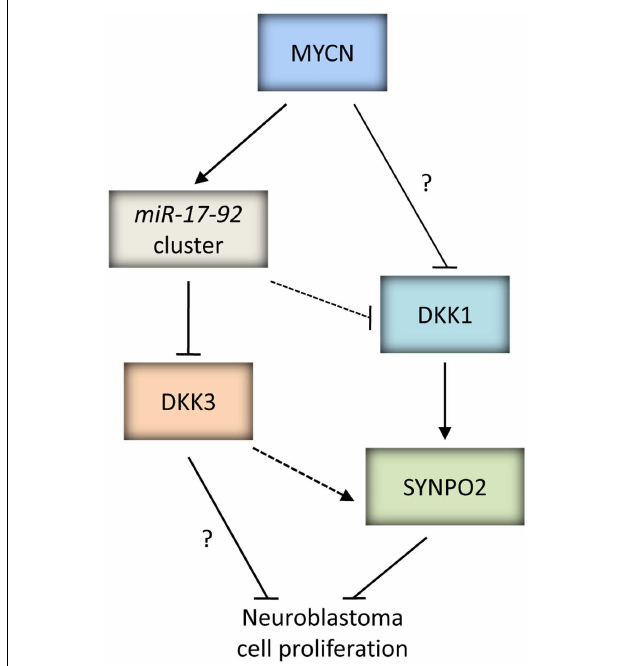
FIGURE 4 | MYCN mediated downregulation of DKK proteins in neuroblastoma. DKK1 and DKK3 can inhibit the proliferation of neuroblastoma cells, therefore downregulation of DKK proteins by MYCN will favor neuroblastoma tumorigenesis. MYCN mediated downregulation of DKK3 can occur via upregulation of the oncogenic miR-17-92 cluster, and due to the homology between DKK family members, this may also be a potential mechanism for MYCN mediated downregulation of DKK1 (as indicated by the dashed line). DKK1 inhibits the proliferation of neuroblastoma cells via upregulation of SYNPO2, and although the mechanism for DKK3 remains unclear, due to the homology between DKK family members this may also occur via SYNPO2 (as indicated by the dashed